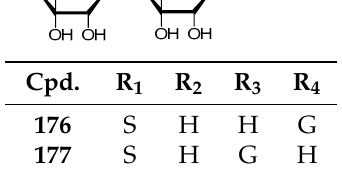
Figure 21. Structure of compound 175 .